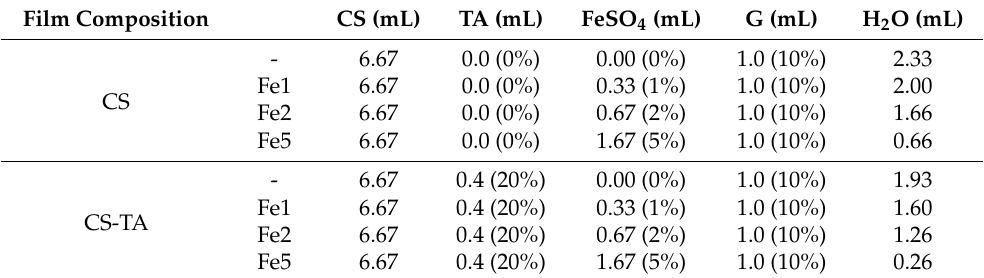
Table 1. Formulations of chitosan films with the respective amounts of solutions employed in their